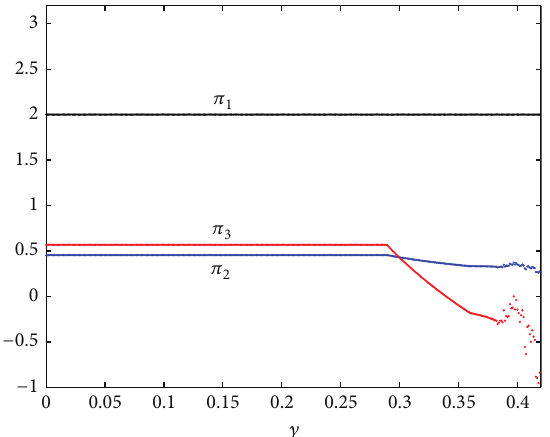
Figure 8: The long-run average profits of the players with 𝛾 for system